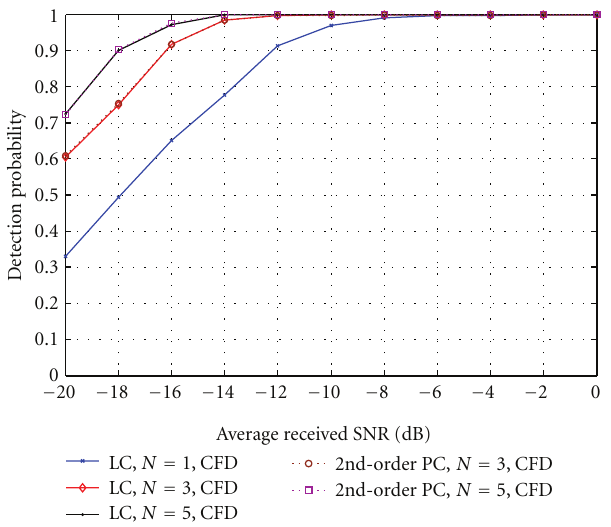
Figure 7: Detection performance for cooperative LC and PC with cyclostationary-based feature extraction: P f = 10% and M =